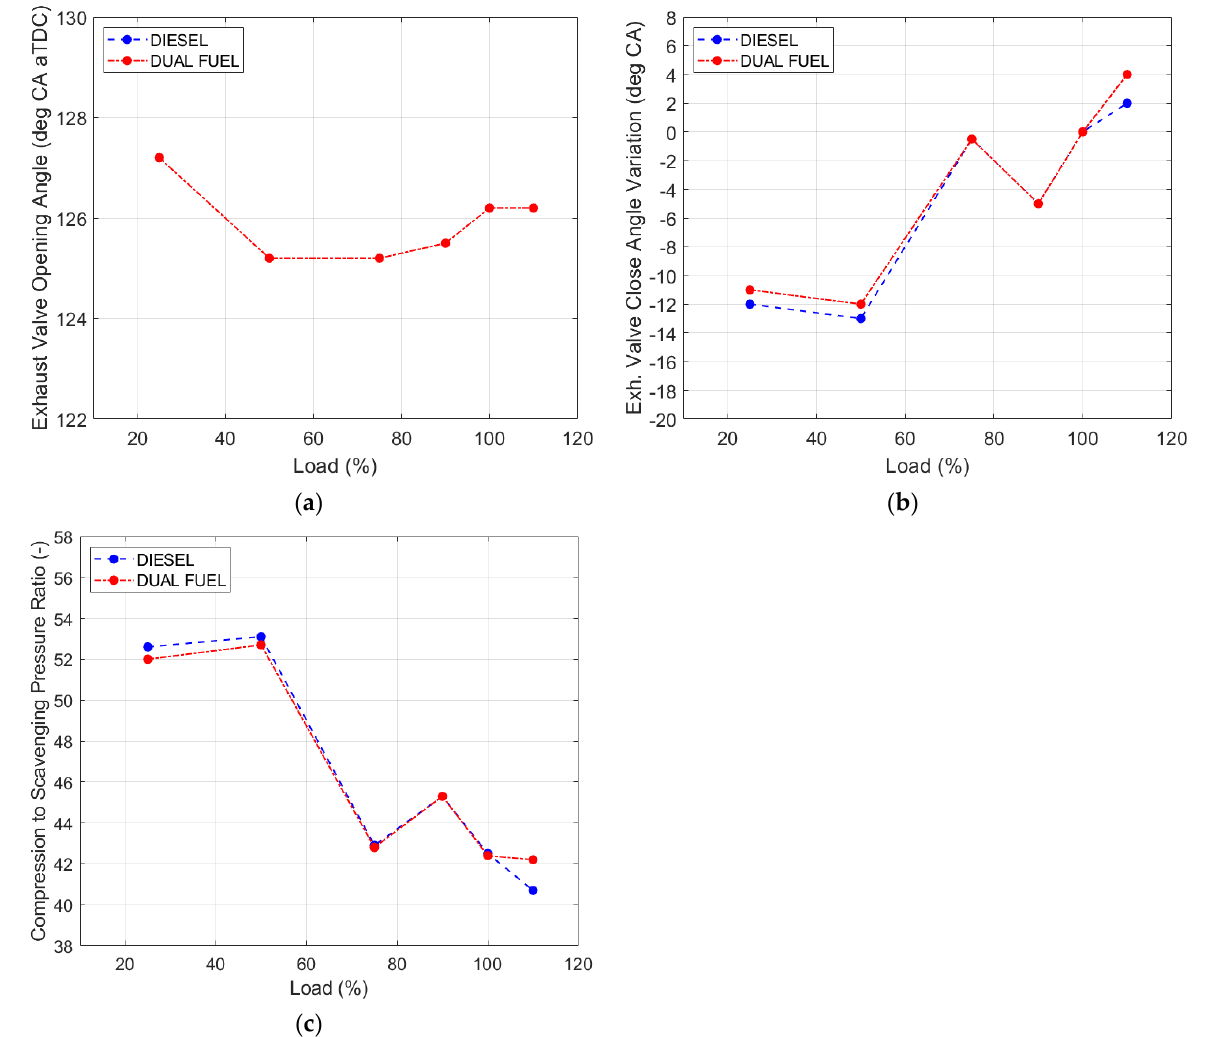
Figure 6. ( a ) Exhaust valve opening angle, diesel and DF modes; ( b ) Exhaust valve closing angle variation, diesel and DF modes; ( c ) E ff ective compression ratio (P comp /P scav ), diesel and DF modes. variation, diesel and DF modes; ( c ) Effective compression ratio (P comp /P scav ), diesel and DF